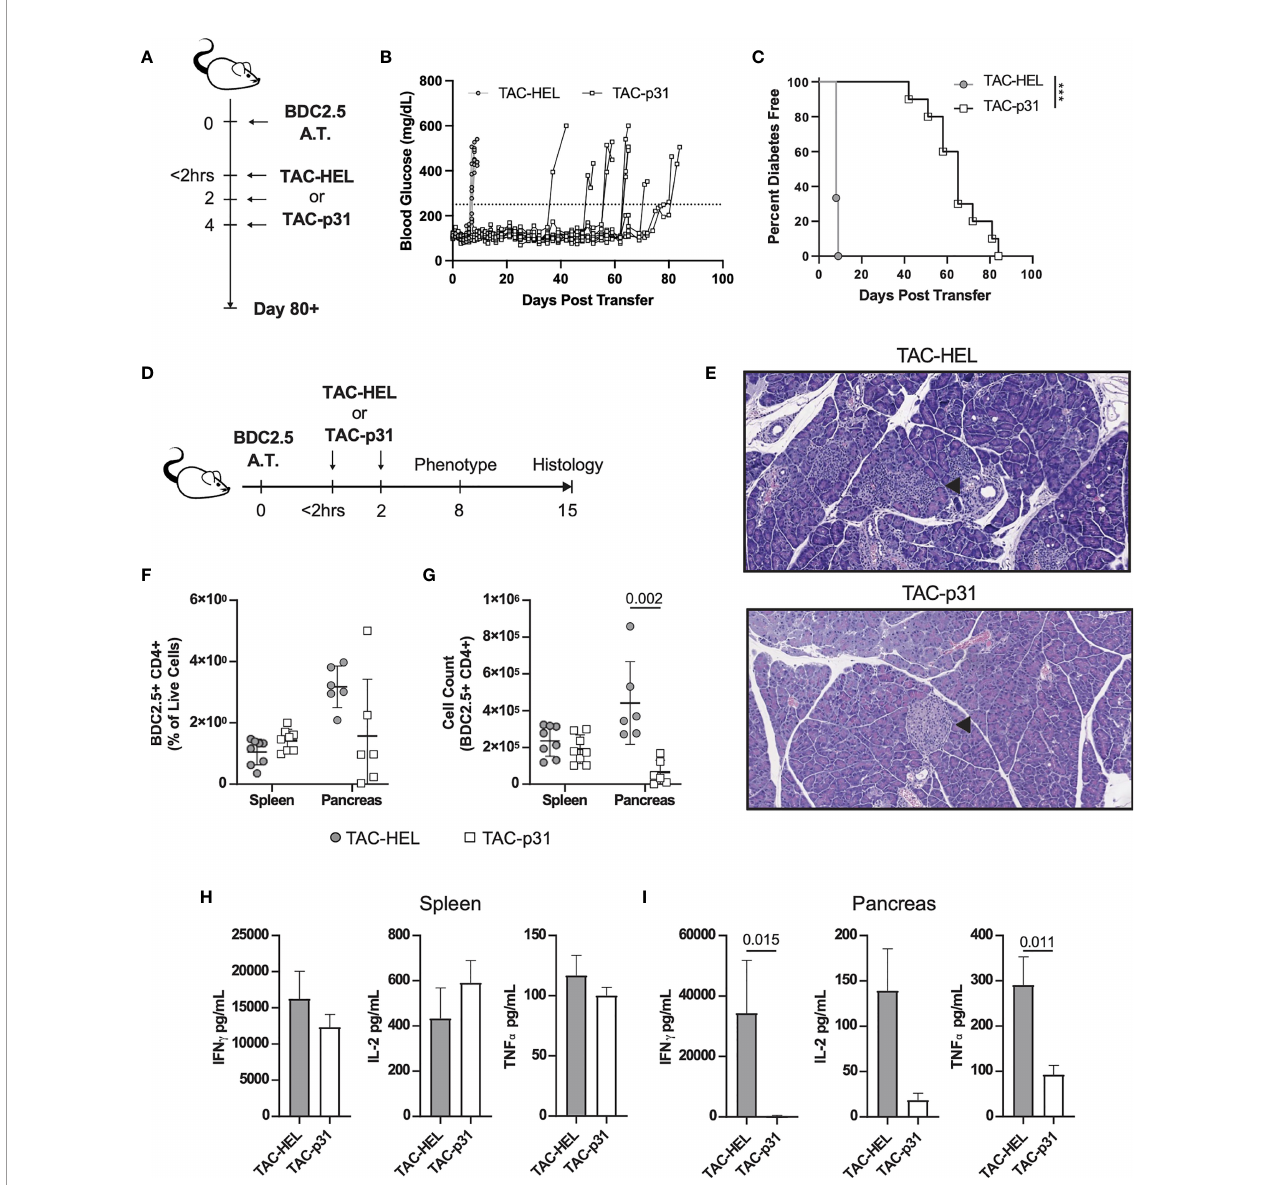
FIGURE 3 | TAC-p31 impairs pancreatic islet in fi ltration and BDC 2.5 effector function. (A-C) 5x10 5 Activated BDC2.5 cells were transferred into NOD. scid mice on day 0. Mice were treated with TAC-HEL (control) or TAC-p31 within 2 hours and on days 2 and 4 post-transfer and monitored for 80+ days. (B) Blood glucose and (C) diabetes disease incidence of mice treated with TAC-HEL or TAC-p31. (B, C) Disease was de fi ned as two consecutive days ≥ 250mg/dL (dotted line). TAC-HEL n = 9, TAC-p31 n = 10. Log-rank (Mantel-Cox) test. (D-I) Activated BDC2.5 cells were transferred into mice on day 0. Mice were treated with TACs within 2 hours and on day 2. (E) Representative H&E staining of pancreata on day 15 post transfer. Arrowhead indicates Islet of Langerhans. n = 2 per group. (F) Frequency and (G) number of BDC2.5 + Cells (CD90.2 + CD4 + BDC2.5 Tetramer + ) in spleens and pancreata of mice on day 8. (H-I) Th1 Cytokine secretion by p31 stimulated cells from the (H) spleen and (I) pancreas on day 8. (F – I) show samples of cells pooled from 2-5 animals. Spleen n = 10, pancreas n=6 pools per group. Mean +/- SD. Mann-Whitney U Test. Data from 2 independent experiments. (A-I) TAC dose was 1x10 9 and peptide squeeze concentration was 200 m M. *** P <